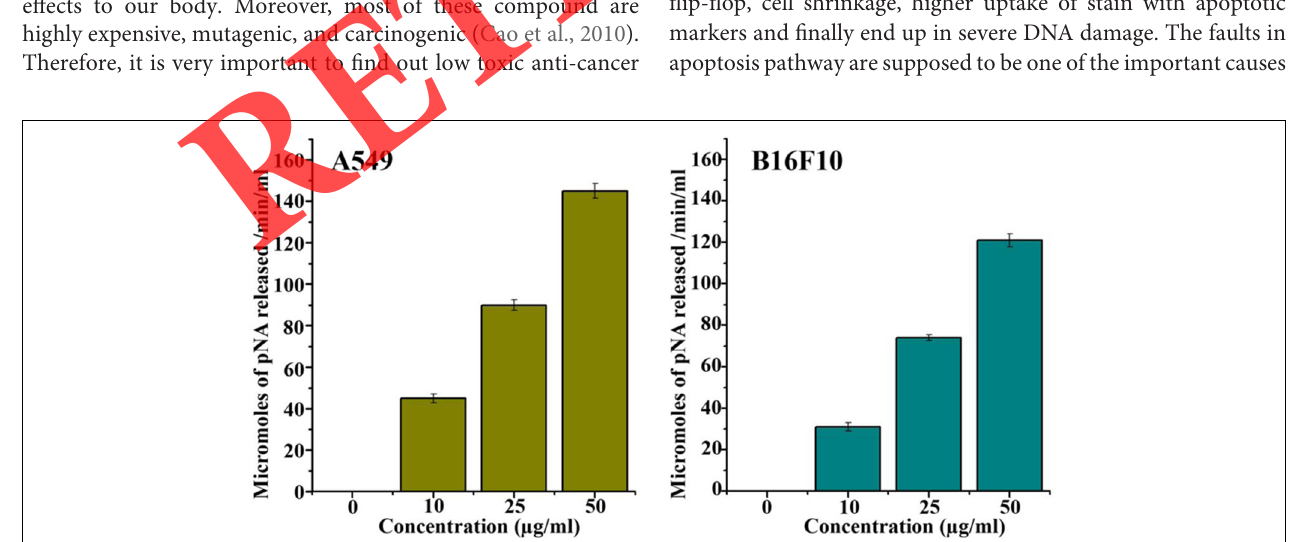
Frontiers in Microbiology |